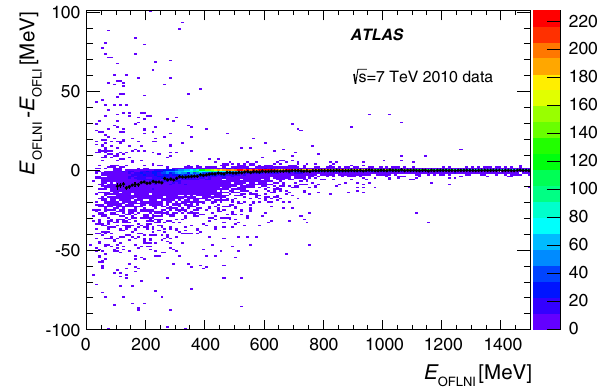
Fig. 4 The absolute difference between the energies reconstructed using the optimal filtering reconstruction method with the non-iterative ( E OFLNI ) and iterative ( E OFLI ) signal reconstruction methods as a func- tion of energy. The black markers represent mean values of E OFLNI – E OFLI per a bin of E OFLNI . The parabolic correction is applied to E OFLNI . The data shown uses high p T ( > 20GeV) isolated muons √ s = 7TeV collisions recorded in from